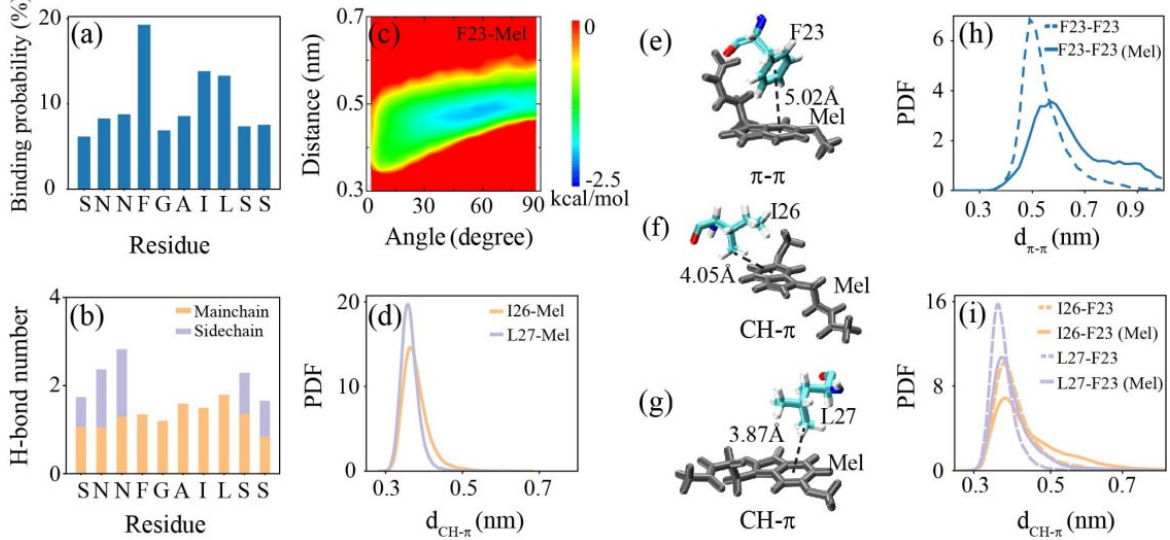
Figure 6. Analysis of the interactions between the hIAPP 20–29 octamer and Mel. ( a ) The binding probability of Mel with each residue of the hIAPP 20–29 octamer. ( b ) The number of H-bonds formed by Mel with the main chain and side chain of individual amino acid residues. ( c ) PMF (in kcal/mol) of aromatic stacking between the closest benzene rings of Phe and Mel, projected in the two-dimensional plane of the angle and centroid distance of the ring pairs. ( d ) PDF of the minimum distance between the methyl group of I26 or L27 and the benzene ring of Mel. ( e – g ) Snapshots of the π – π and CH– π interactions formed in a trajectory. ( h ) PDF of the centroid distance between the closest pairwise rings of F23 residues in the absence and presence of Mel. ( i ) PDF of the minimum distance between the methyl group of I26 or L27 and the benzene ring of F23 in the absence and presence of Mel.